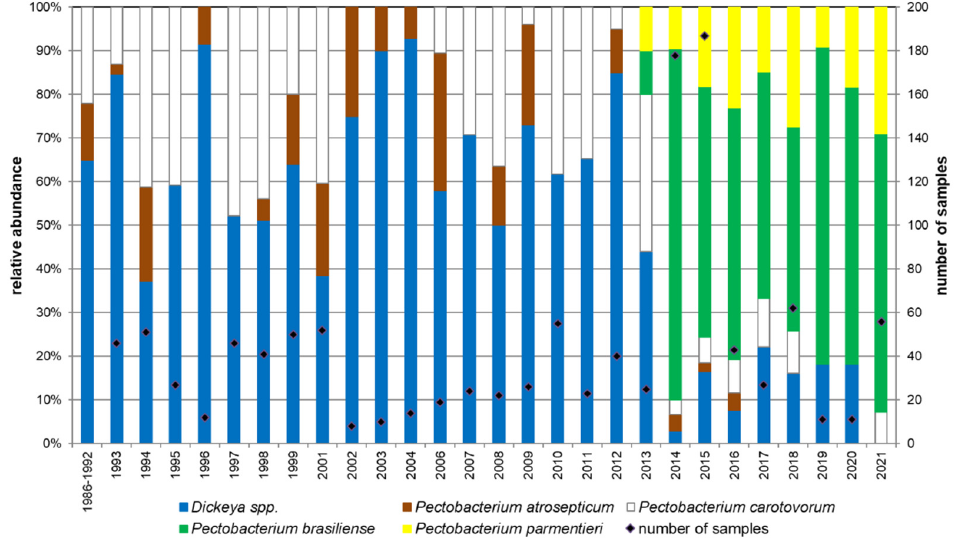
Figure 7. Relative abundance of different potato blackleg-inducing bacterial species sampled during the yearly Swiss survey from 1993 to 2021. Data until 2018 are already published elsewhere [11].